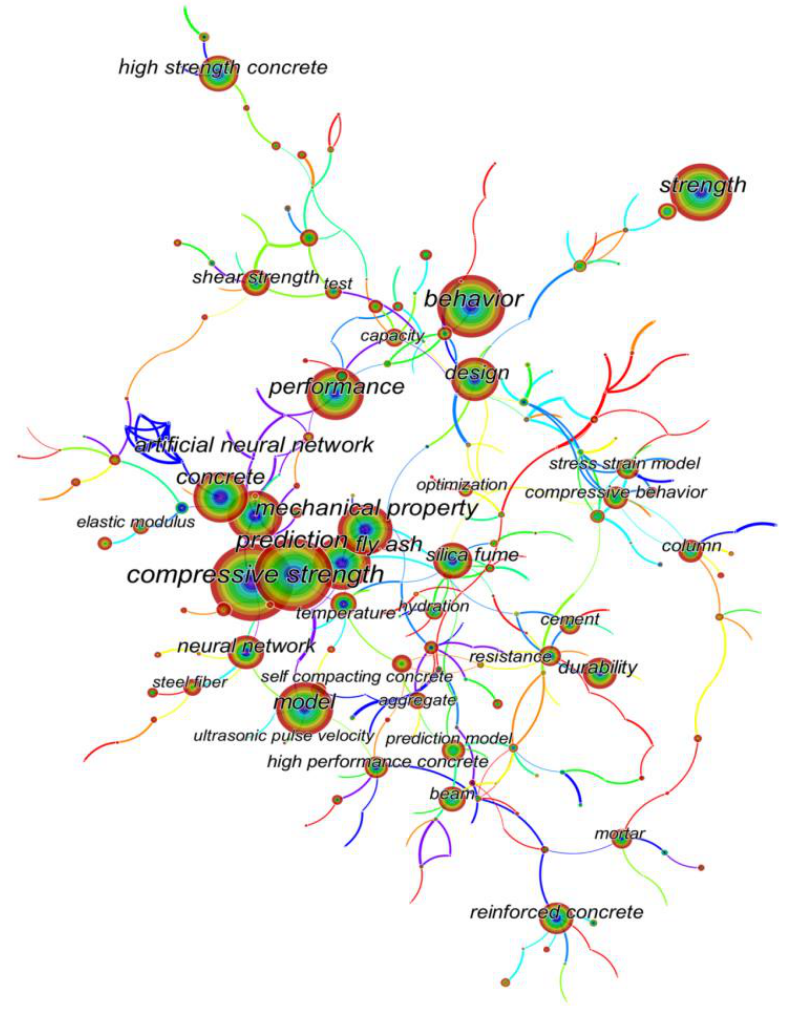
Figure 6. Co-occurrence network map of hot